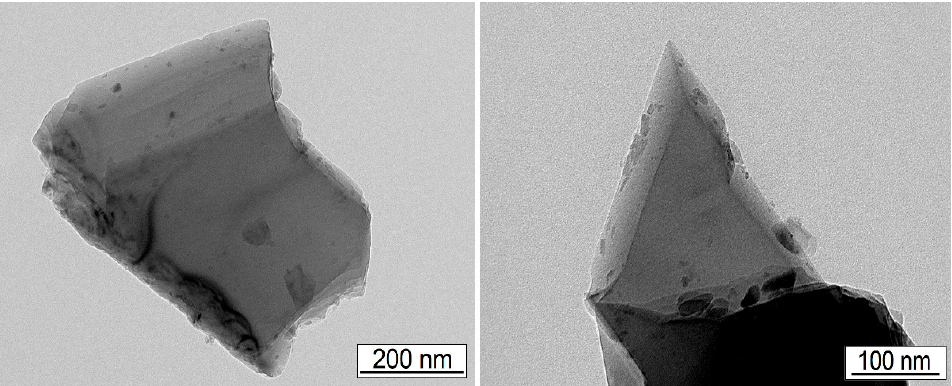
Figure 2. TEM images of the diamond powder with 500 nm fraction. The XRD diffraction pattern of initial diamond particles is shown in Figure 3. Two distinct peaks characterize the diamond phase; there were no metal impurities detected.